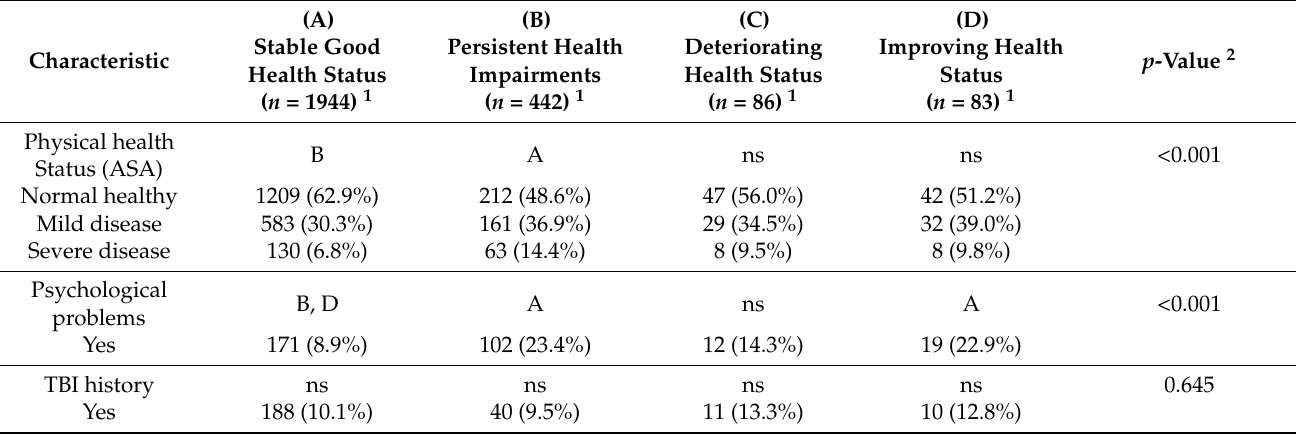
Table A12. Descriptive premorbid and injury-related statistics for the four classes of TBI-specific and generic HRQoL